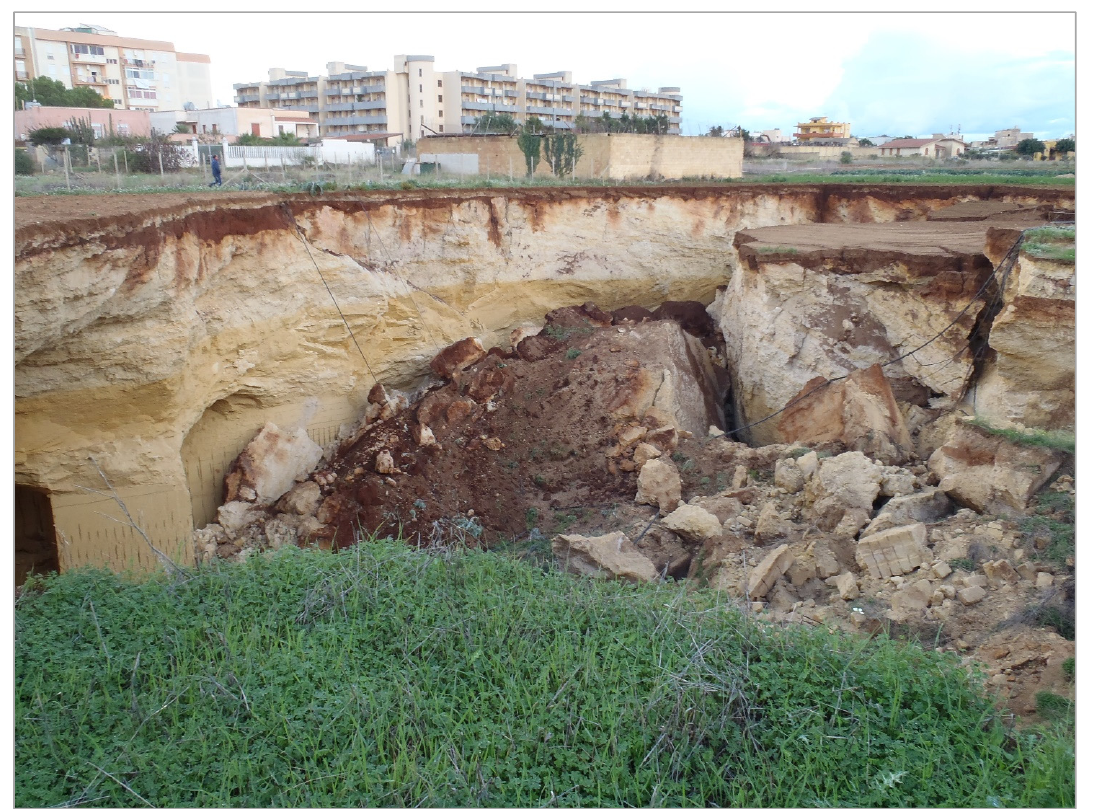
Figure 9. Sinkhole occurrence in urbanized areas can pose serious risks to society, threatening buildings and infrastructures.